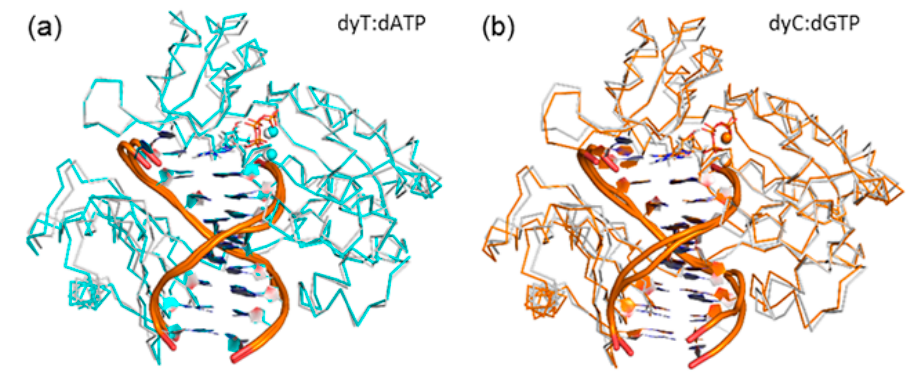
Figure 7. Overlay of the C α protein backbone in representative MD structures of the Dpo4 ternary complex for the replication of: ( a ) dyT (blue); or ( b ) dxC (yellow), and dT (white). See Figure S10 for all systems.